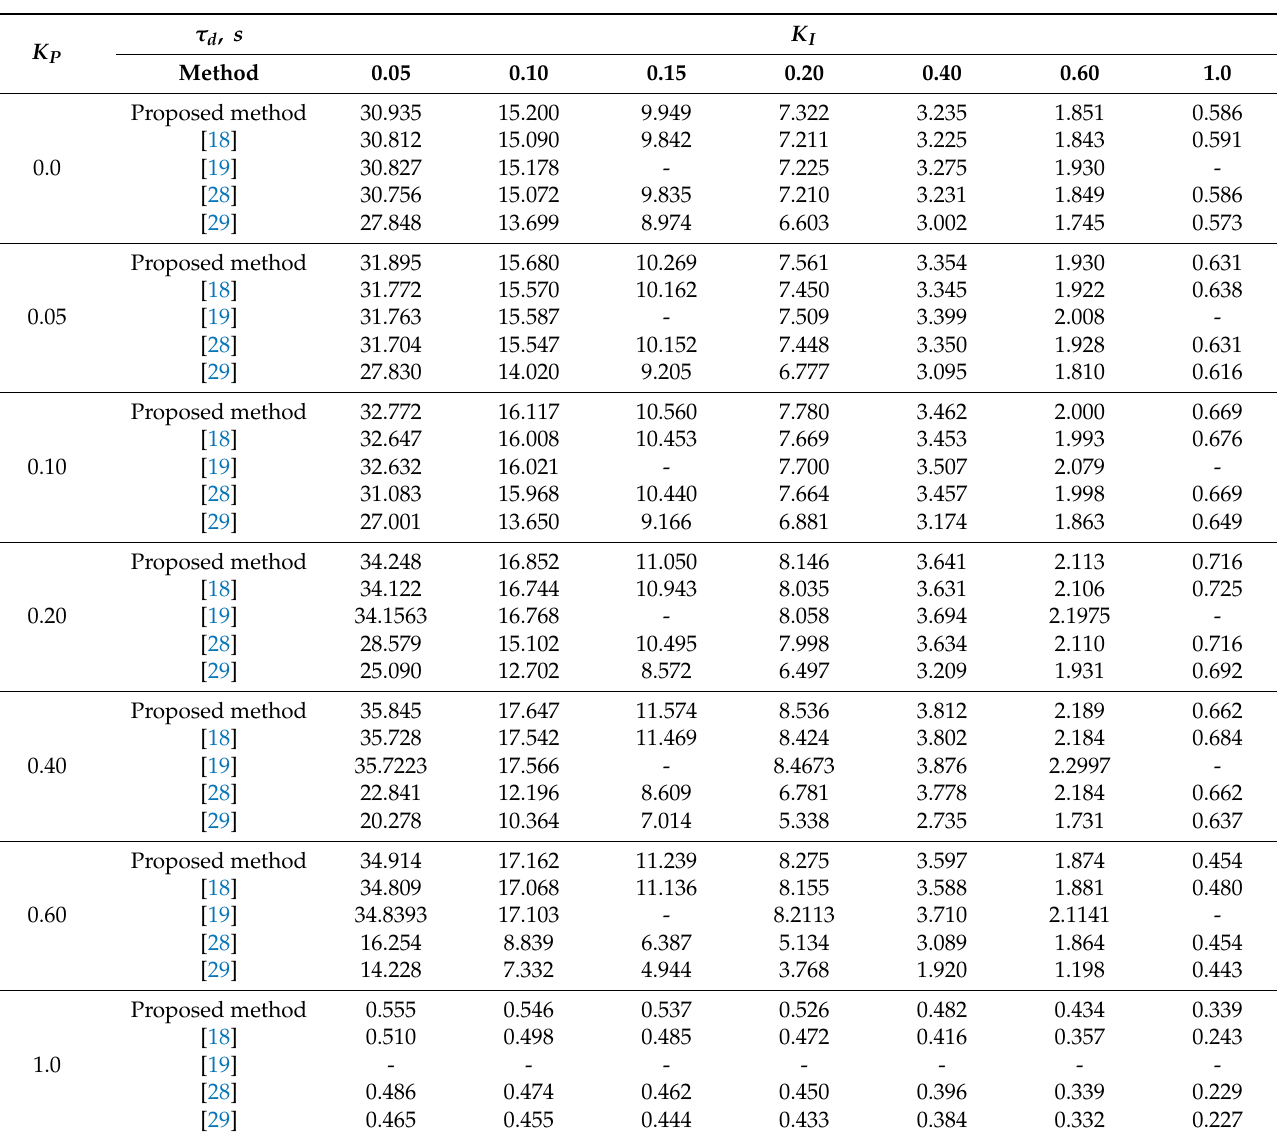
Table 1. The DM for various K P and K I